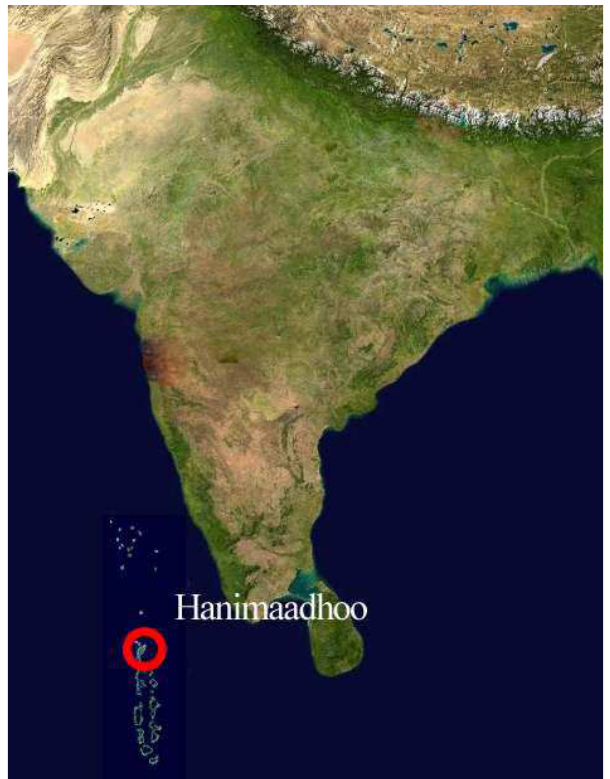
Fig. 1. The location of the station MCOH in the Maldives (longitude 73 ◦ 10 0 59 00 E, latitude 6 ◦ 46 0 34 00